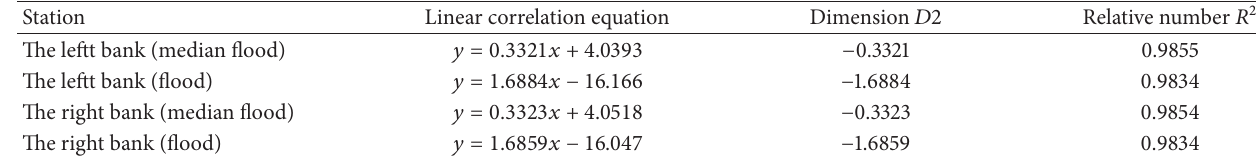
Table 4: The second-order accumulated fractal dimension of the